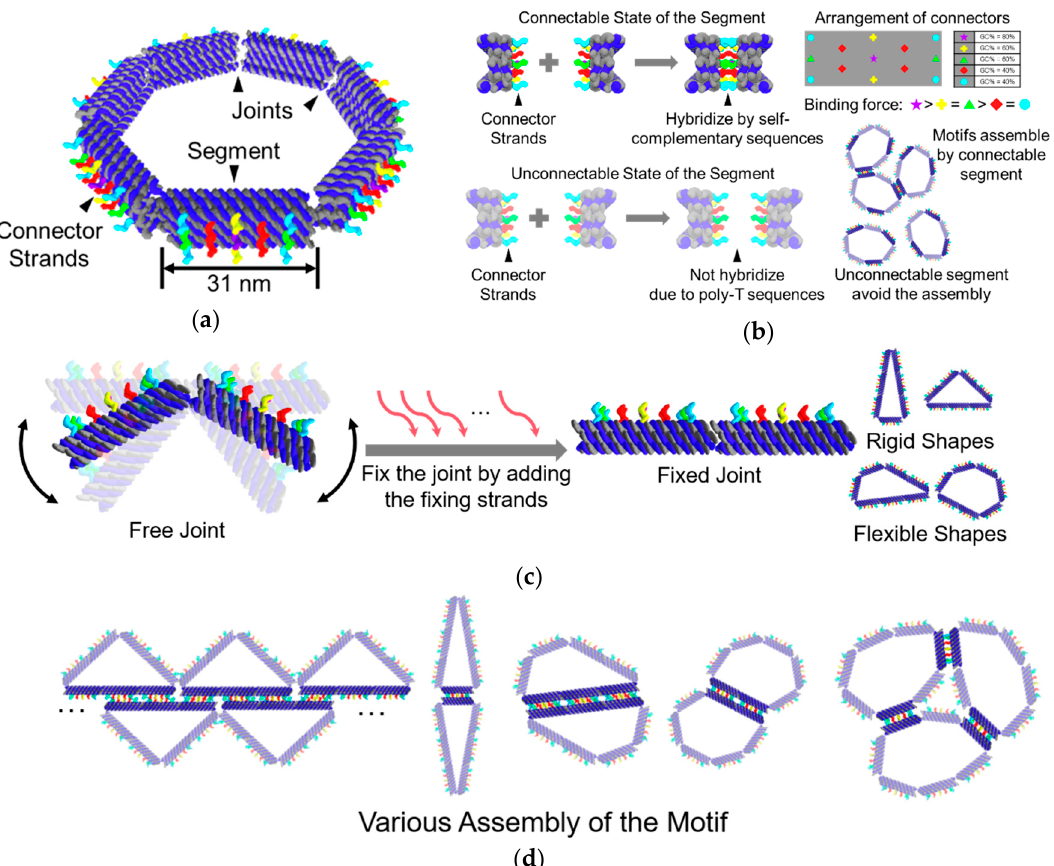
Figure 1. Overall design of the DNA ring motif. ( a ) Schematic of the motif in heptagonal shape; ( b ) The connector strands on the segment of the motif. The state of the segment can be selected as connectable or unconnectable. The connector strands are arranged symmetrically on the segment. The binding force are different for the connector strands at different locations. ( c ) The shape control of the motif. The motif can take different shapes by fixing the free joints at different positions; ( d ) Examples of the self-assembled structures of the motif.